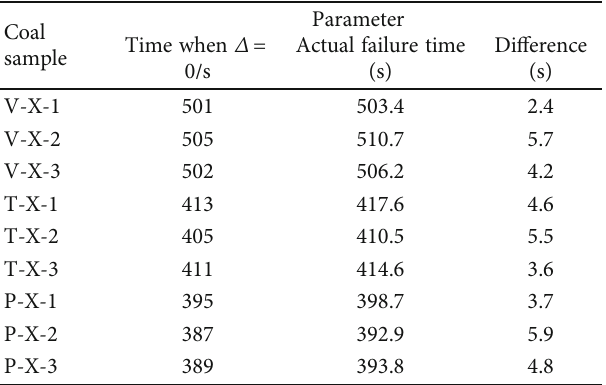
Table 3: Acoustic emission prediction of coal sample unloading failure.